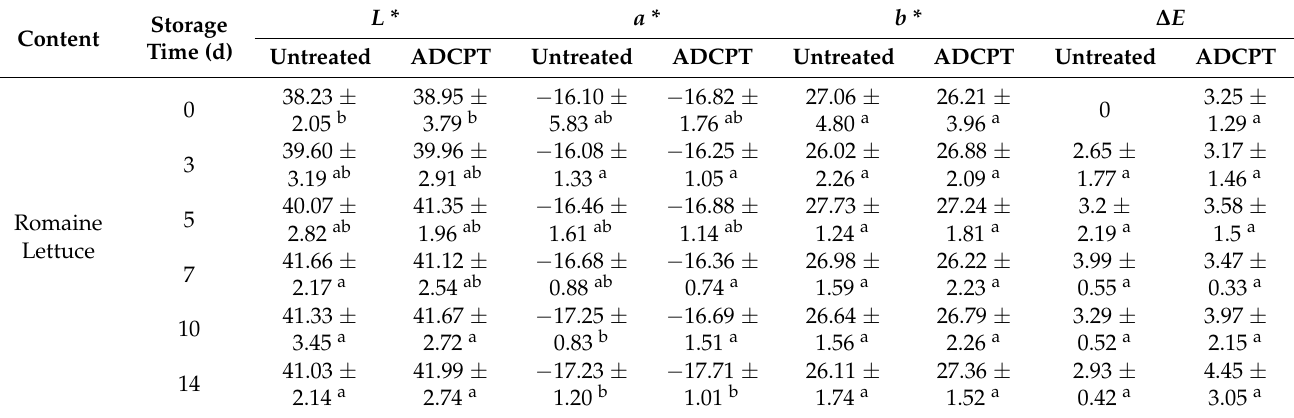
Table 2. Effects of atmospheric dielectric barrier discharge cold plasma (ADCP) treatment at 24 kV for 2 min on the color of salad during storage at 4 ◦